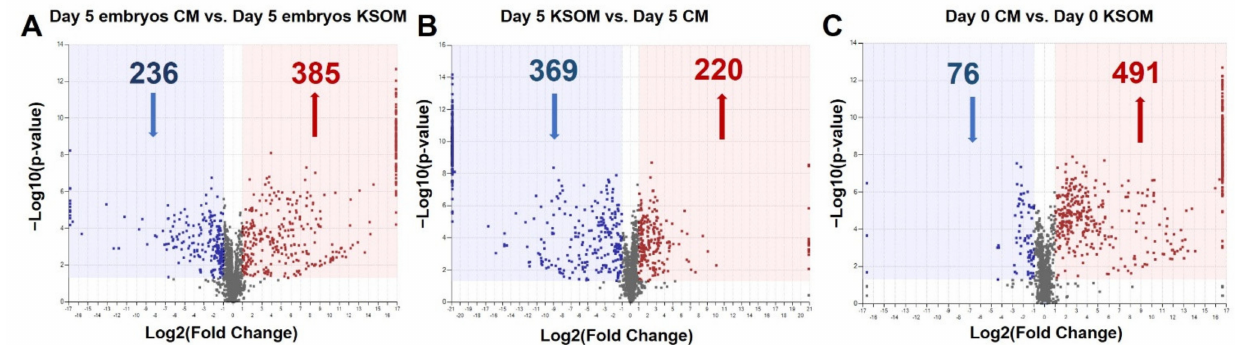
Figure 4. Volcano plot showing the distribution of metabolic compounds for the pairwise comparison. Pairwise comparison of ( A ) day 5 embryo culture CM vs. day 5 embryo culture KSOM, ( B ) Day 5 CM vs. Day 5 KSOM, and ( C ) Day 0 CM vs. Day 0 KSOM. Significance criteria: p ≤ 0.05, fold change ≥ |2|. Volcano plots combine the p -value measured by ANOVA, expressed as − log 10 ( p -value), with the magnitude of the change in relative abundance, expressed as log 2 (fold change), between the groups considered in a particular pairwise